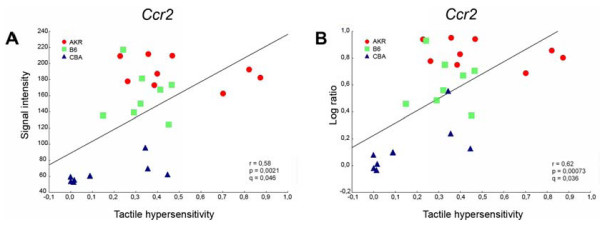
Regulation of expression of the cytokine receptor Ccr2 after L5 SNL correlated positively with the degree of tactile hypersensitivity. Each symbol represents one mouse of the AKR, CBA or B6 strain. Expression data, for individual mice, are plotted as: A, the raw signal intensity values associated with Ccr2 gene expression, and B, the log ratio of the signal intensity of the individual mouse divided by the average signal intensity of all sham operated mice of the same strain. Values for tactile hypersensitivity of the individual mice were normalized as indicated in the Methods, where increasing values indicate greater sensitivity. r = Pearson correlation coefficient, p = statistical significance of r, q =false discovery rate (FDR) coefficient associated with Ccr2 in the microarray analysis.